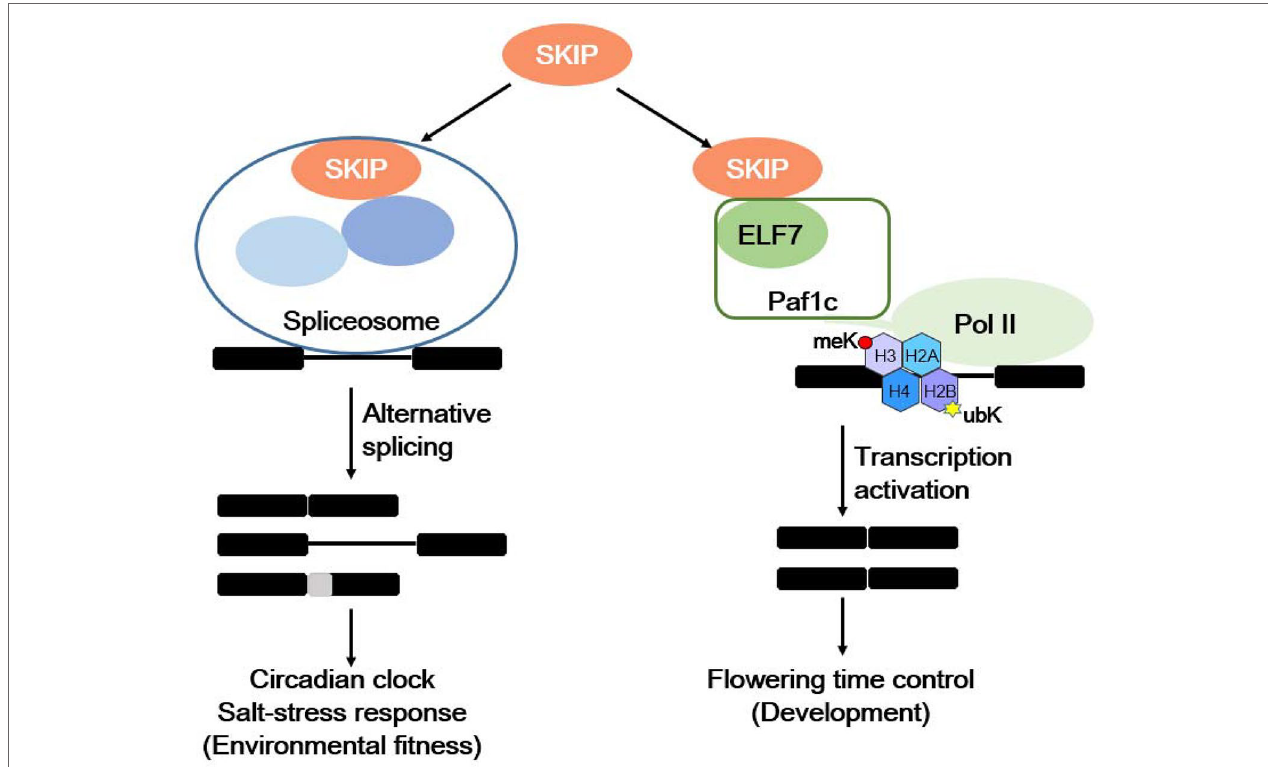
FIGURE 2 | The dual functions of SKIP in mediating environmental fitness and development in plants. SKIP is a splicing factor that regulates the alternative splicing of clock and stress tolerance-related genes in order to mediate the circadian clock and stress responses. It also functions as a transcriptional coactivator by interacting with RNA polymerase II-associated factor 1 complex (Paf1c) to activate FLC/MAFs transcription and mediate the floral